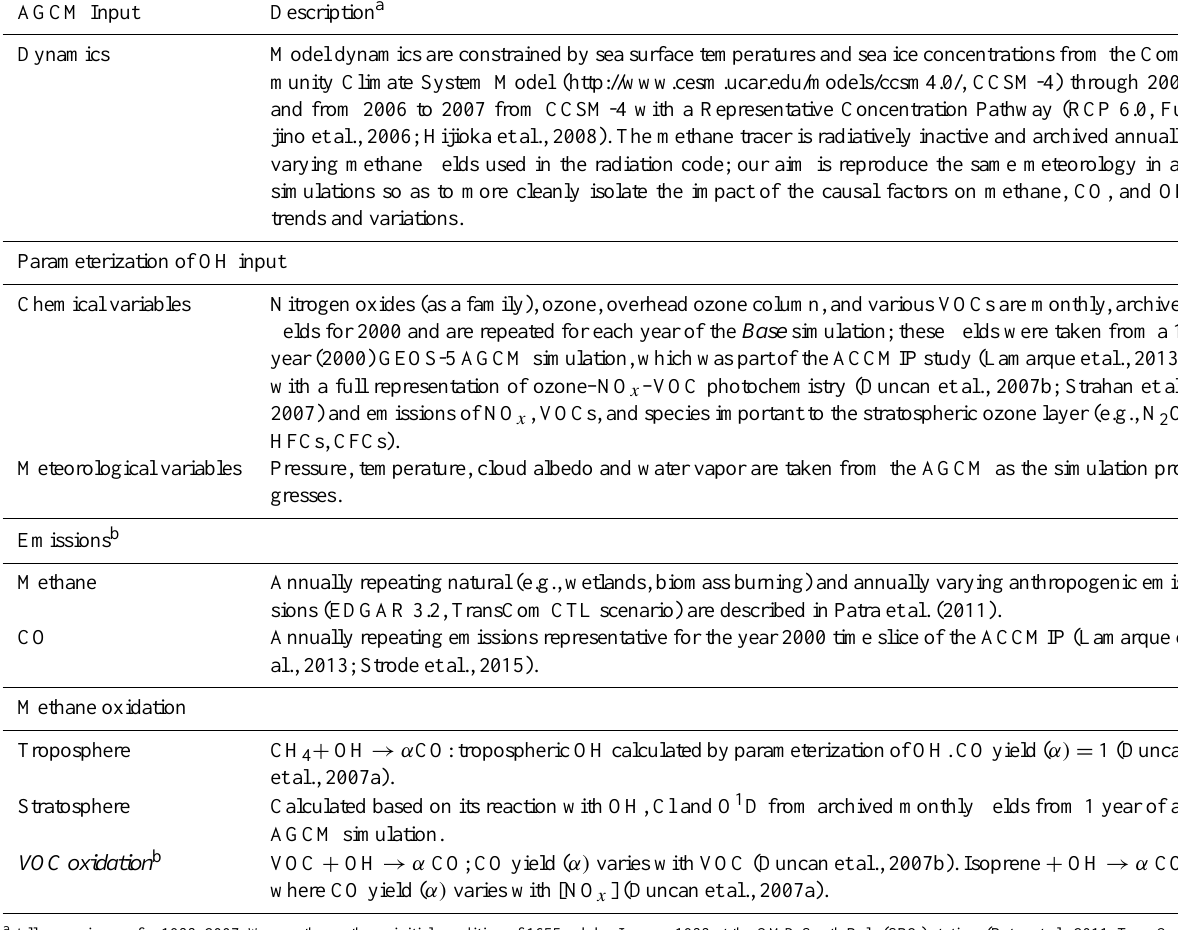
Table 1. Reference scenario ( Base )